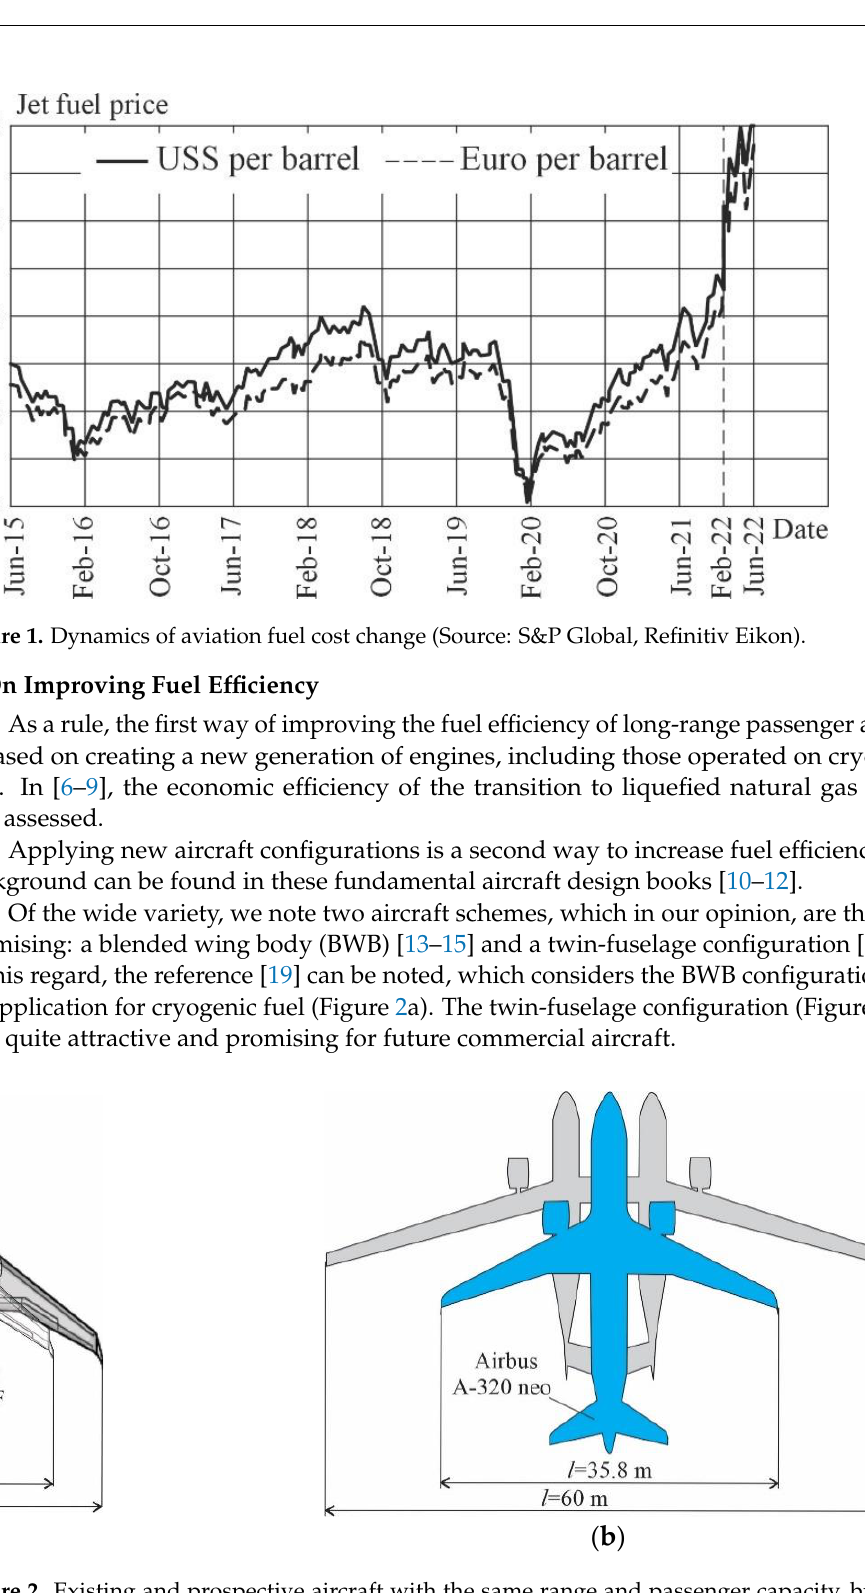
Figure 1. Dynamics of aviation fuel cost change (Source: S&P Global, Refinitiv Eikon).